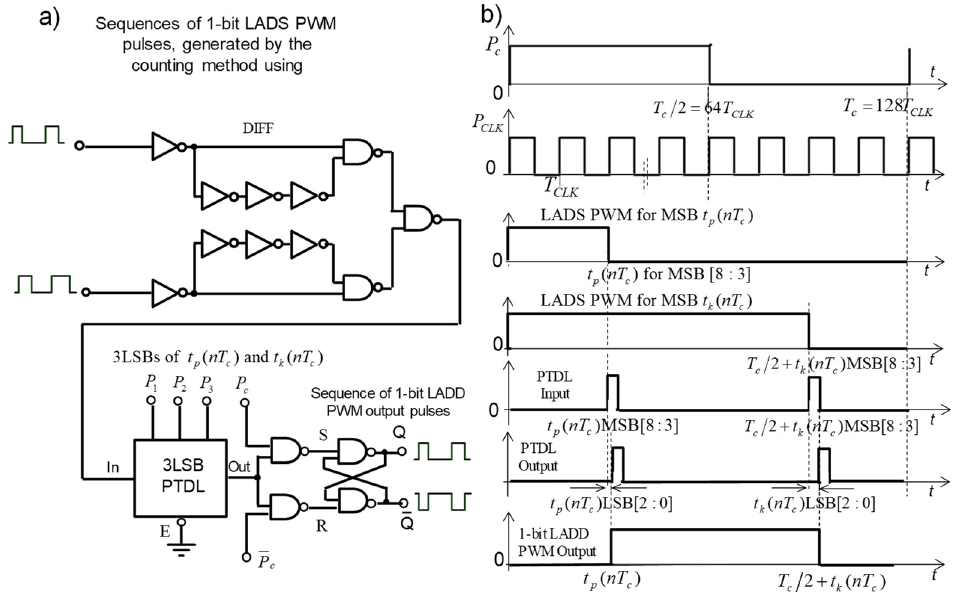
Figure 2. Conversion of the calculated and requantized 3 LSB LADD PWM audio data into a sequence of 1 bit LADD PWM pulses: ( a ) logical scheme of the LADD subsystem; ( b ) the control and output signals.